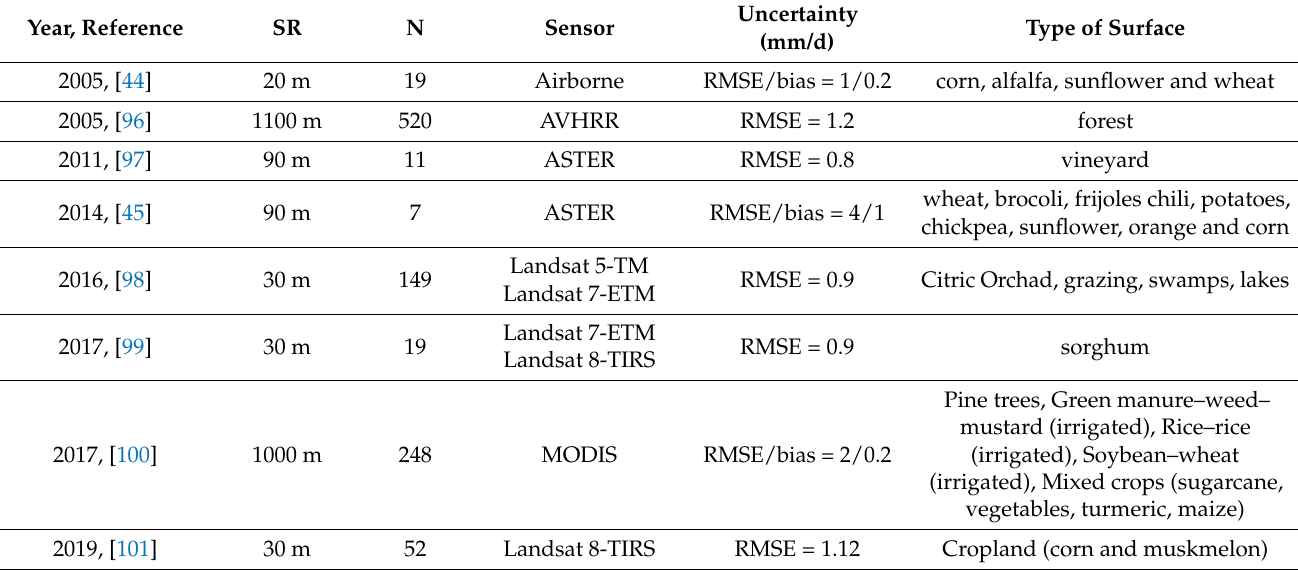
Table 1. Representative chronological compendium of validation studies of the S-SEBI method. Reference, spatial resolution (SR), number (N) of satellite scenes, Sensor Name, Uncertainty and Type of Surface are detailed (uncertainty statistics are averaged values of all type of surface